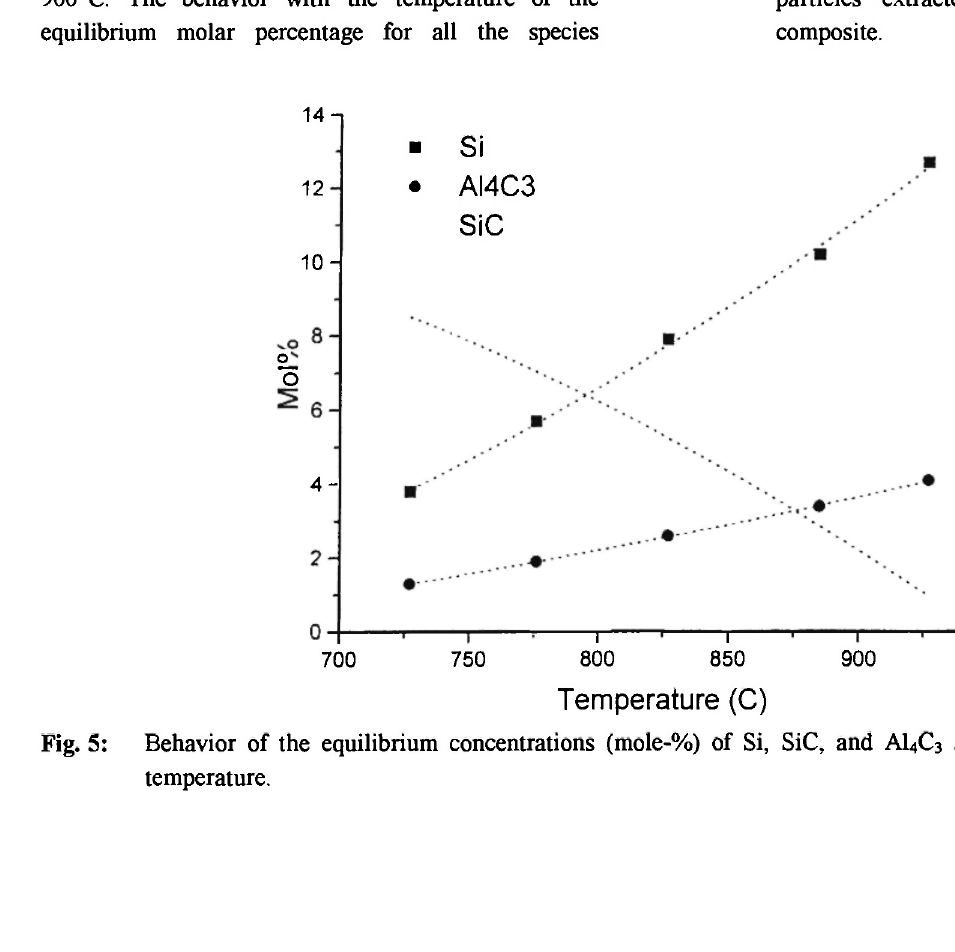
Fig. 4: SEM-micrograph of SiC reinforcement particles extracted from the as-extruded composite.